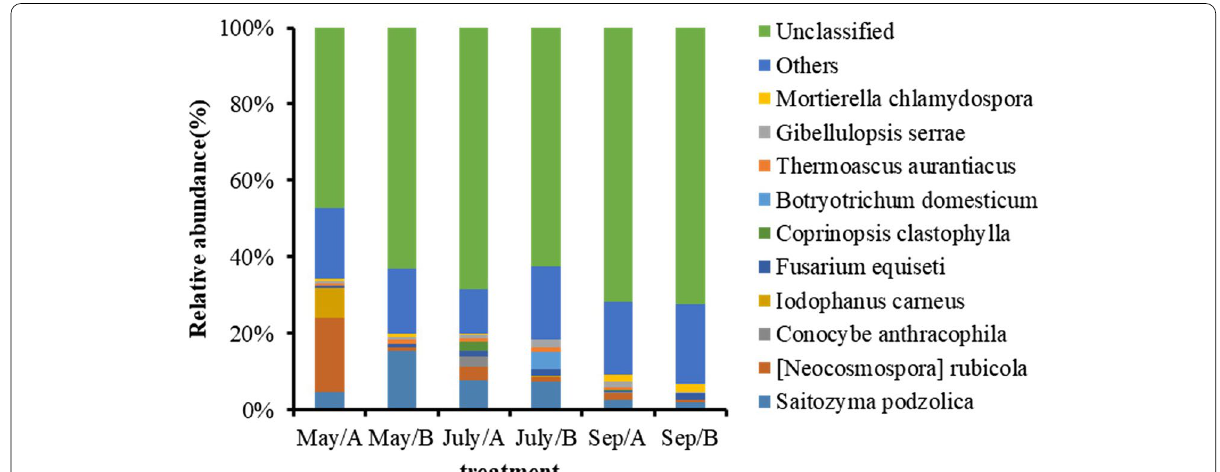
Fig. 5 Relative abundance of main fungal populations in soil in banana intercropping and monoculture. May/A May/B Monoculture treatment in May. July/A = treatment in September.